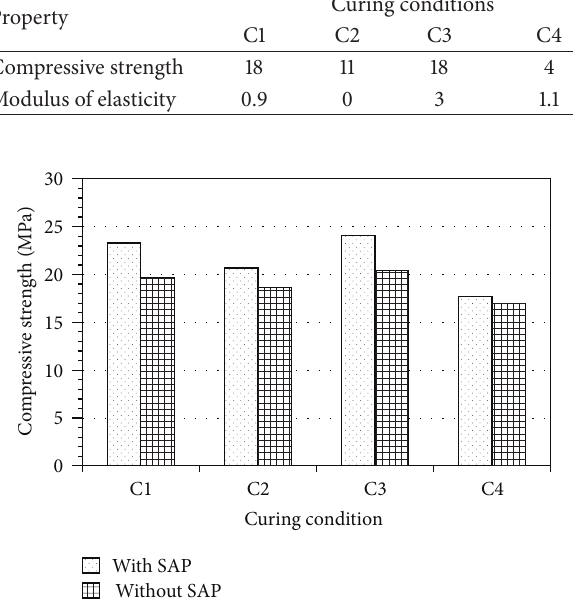
Figure 6: Test results on compressive strength of different type of concrete.